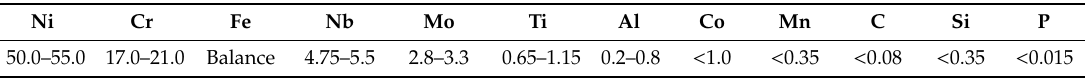
Table 1. Chemical composition of Inconel 718 (wt. %).